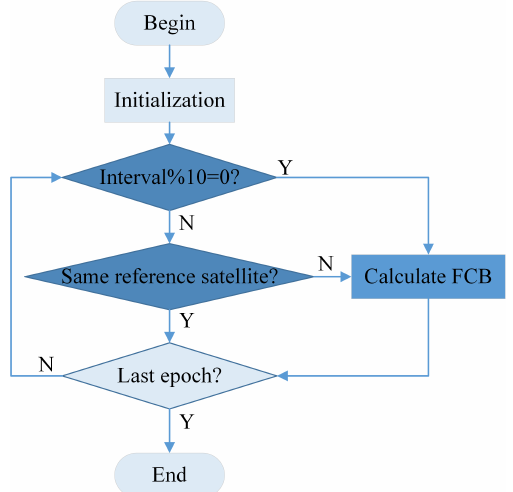
Figure 3. The flowchart of fractional cycle bias (FCB) estimation